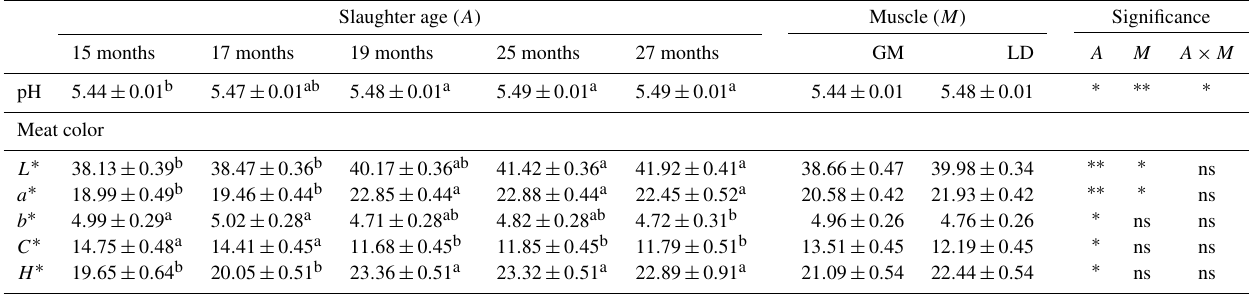
Table 1. Effect of slaughter age and muscle type on pH and color parameters (mean ± SEM). Slaughter age ( A